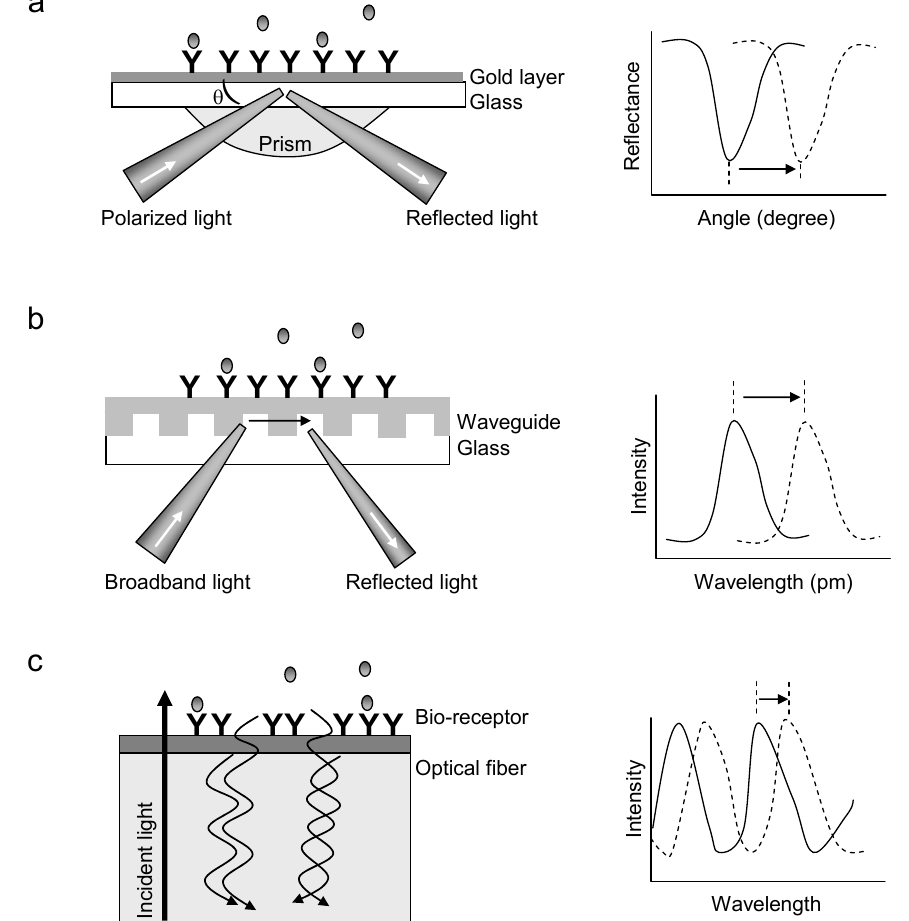
Figure 1. Principles of three types of optical biosensors for biomolecular interaction analysis. (a) SPR. The receptor (Y) is covalently coupled to the derivatized surface of a thin layer of gold, which is deposited onto a glass substrate. The light incident on the gold layer is directed by a prism. The reflectance of the gold surface is a function of incident angle. The resonance angle shifts when target molecules ( (cid:121)(cid:121)(cid:121) ) in solution bind to the immobilized receptors. (b) RWG biosensor. The coupling of incident light into the waveguide is achieved by the diffraction grating. The intensity of reflected light is a function of the resonant wavelength. The binding of target molecules in a sample to the immobilized receptors results in a shift in the resonant wavelength. (c) Interferometric biosensor. A broadband light resource is directly incident at the solution-surface interface. Two types of reflected light waves originated from the two reflecting surfaces, the interface with the optical layer and the surface of bio-receptors, interact each other, leading to interference patterns. The binding of biomolecules to the bio-receptors alters the inference